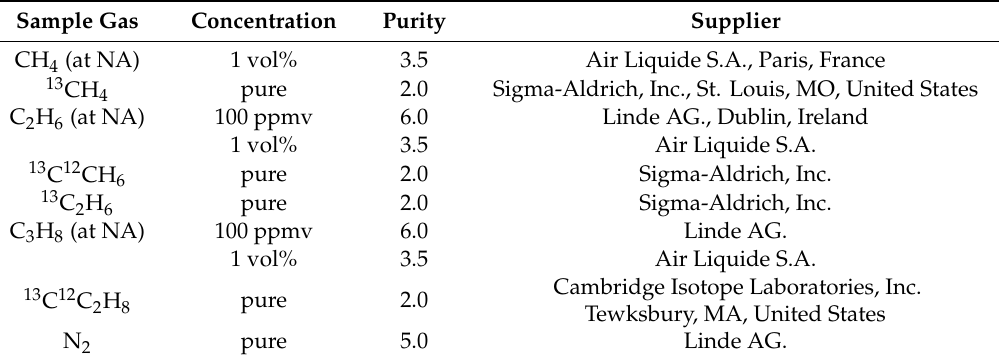
Table 1. Sample gases used in this